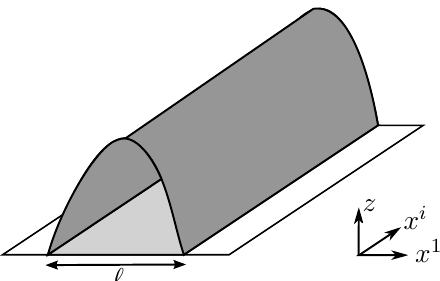
Figure 2. Boundary region and associated bulk surface. The strip has the width ‘ in direction x 1 and length ~ ‘ (cid:29) ‘ in the directions x i with i = 2 ; (cid:1) (cid:1) (cid:1) ; n . The remaining directions (i.e. x j with j = n + 1 ; (cid:1) (cid:1) (cid:1) ; d (cid:0) 1) are not